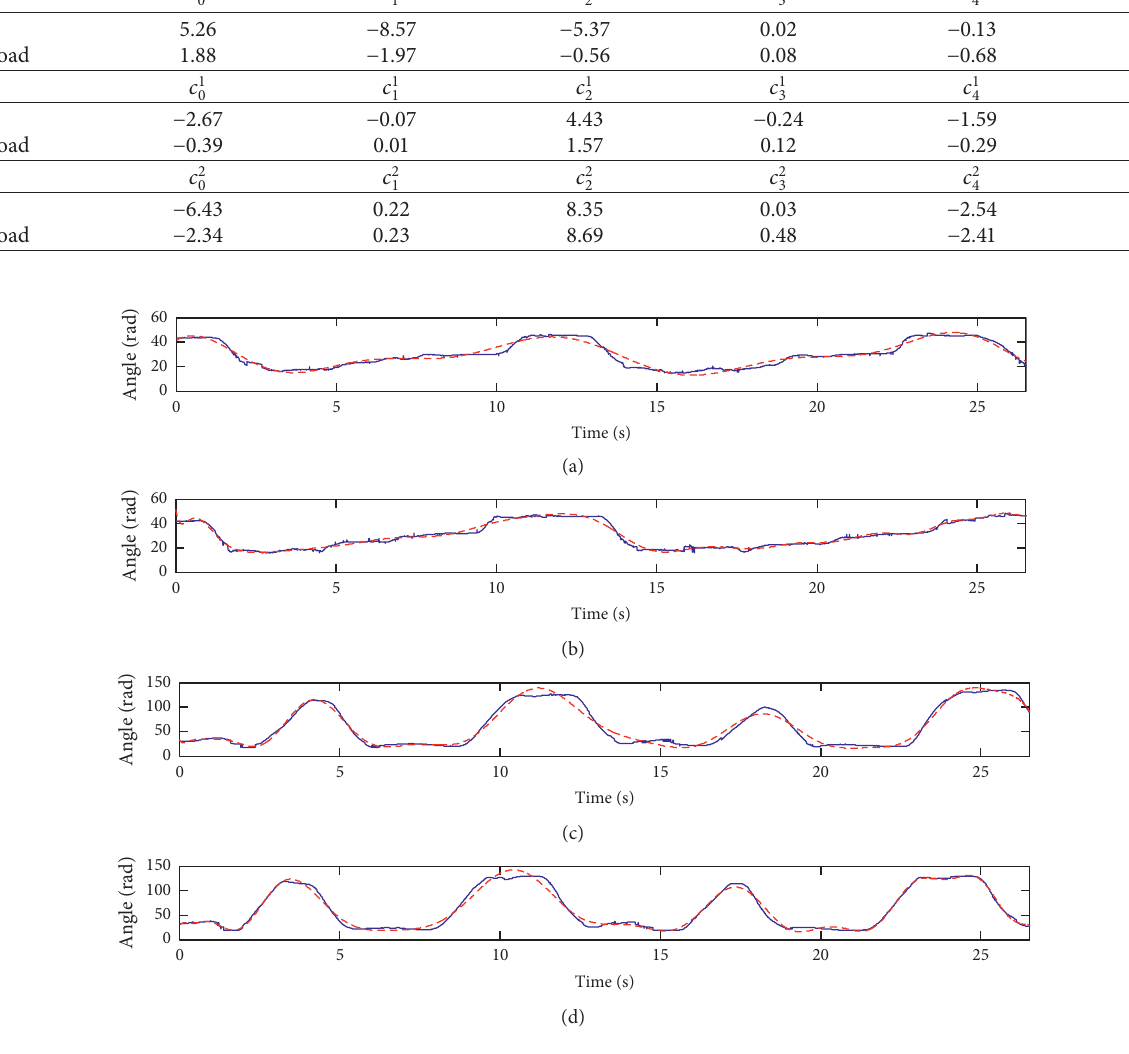
Figure 9: (a) Real and estimated shoulder joint angles without load. (b) Real and estimated shoulder joint angles with load. (c) Real and estimated elbow joint angles without load. (d) Real and estimated elbow joint angle with load. Red indicates estimated value; blue indicates Codamotion measurement. Table 2: Evaluation of the performance of the proposed model (RMSE: root mean square error, CC: correlation coefficient).